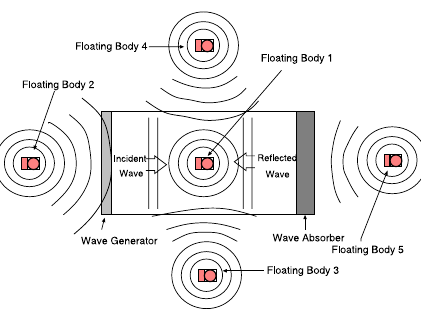
Fig. 6 Wave Condition in the steady